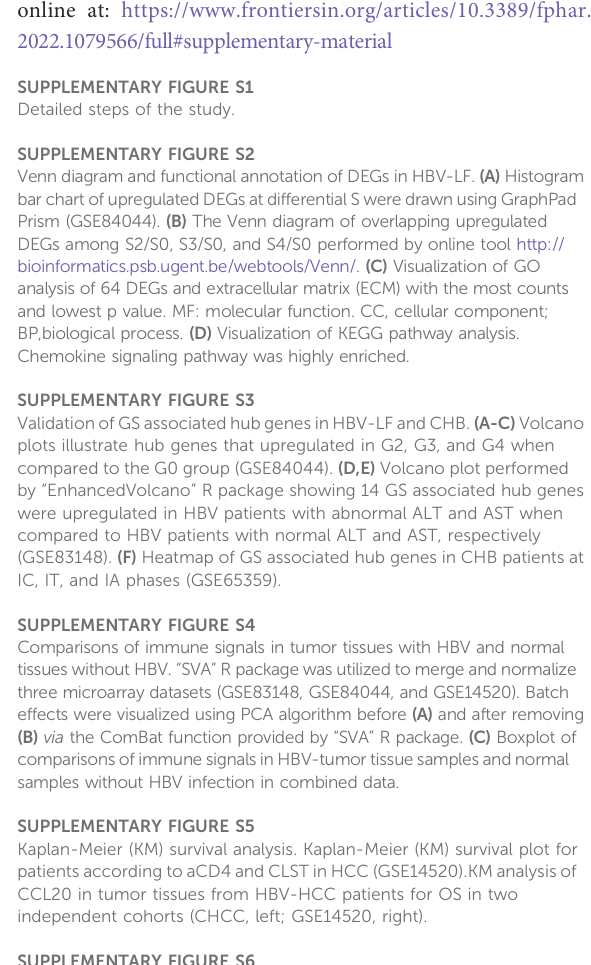
SUPPLEMENTARY FIGURE S5 Kaplan-Meier (KM) survival analysis. Kaplan-Meier (KM) survival plot for patients according to aCD4 and CLST in HCC (GSE14520).KManalysisof CCL20 in tumor tissues from HBV-HCC patients for OS in two independent cohorts (CHCC, left; GSE14520, right). SUPPLEMENTARY FIGURE S6 OSanalysisoffeaturegenesbelongingtoaCD4.Theassociationbetween each of feature genes belonging to aCD4 and OS probability in HBV- HCC tumor tissues (CHCC). Time was calculated by year. SUPPLEMENTARY FIGURE S7 SVMoutperformedinnineAIalgorithmsforHCCtumortissueidenti fi cation. (A) Comparison of nine AI algorithms based on expression value of 15 feature genes as a prognostic set with ACC calculation for HCC tumor identi fi cationamongHCCtumor,adjacentnon-tumor,cirrhoticandhealthy liver samples (GSE25097). (B) Comparison expression value of fi fteen feature genes based on nine AI algorithms with ACC calculation for predicting tumor tissue at early stage of HCC